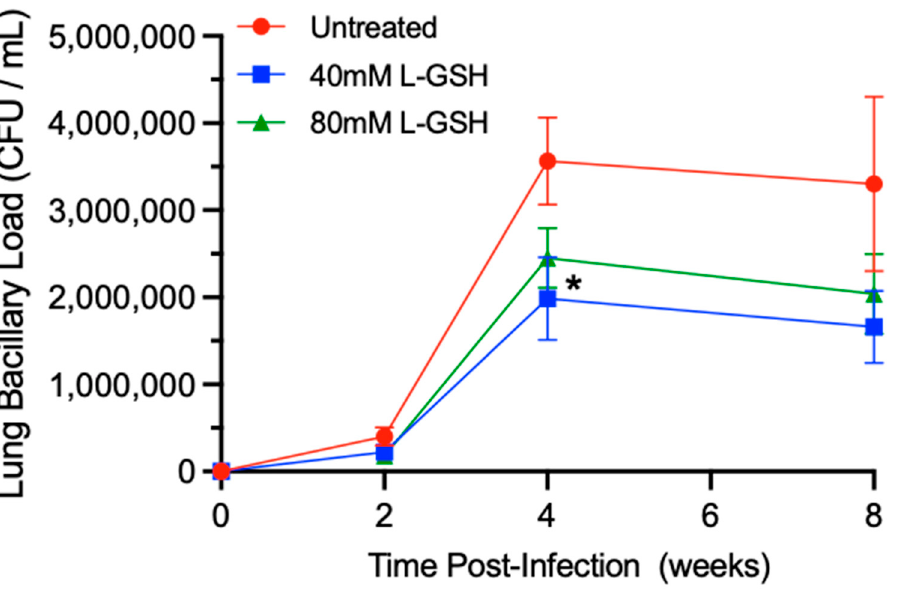
Figure 5. L-GSH supplementation reduced the survival of M. tb in the lungs of the L-GSH-treated mice. M. tb survival was quantified in the lung homogenates of untreated (UT) and the 40 mM or 80 mM L-GSH-treated mice at 2 weeks, 4 weeks, and 8 weeks post-infection. The bacterial CFU assay was performed to determine the bacterial survival in the lungs. All of the values plotted for each group represent the mean values +/ − standard deviation. One-way ANOVA with Tukey’s multiple group post correction was applied to determine the significance between the groups and a p -value of <0.05 (*) was considered significant. Statistical analysis was performed using GraphPad Prism Software 8. The sample size is 6 mice (n = 6) per group, per time